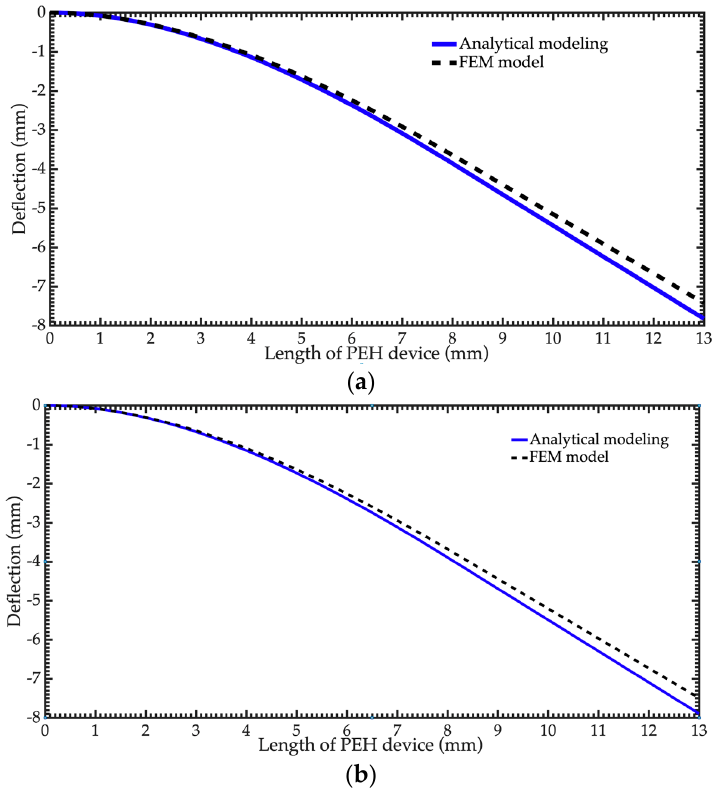
Figure 7. Maximum displacements of the PEH devices at resonance with ZnO ( a ) and PZT-5A ( b ) layers.